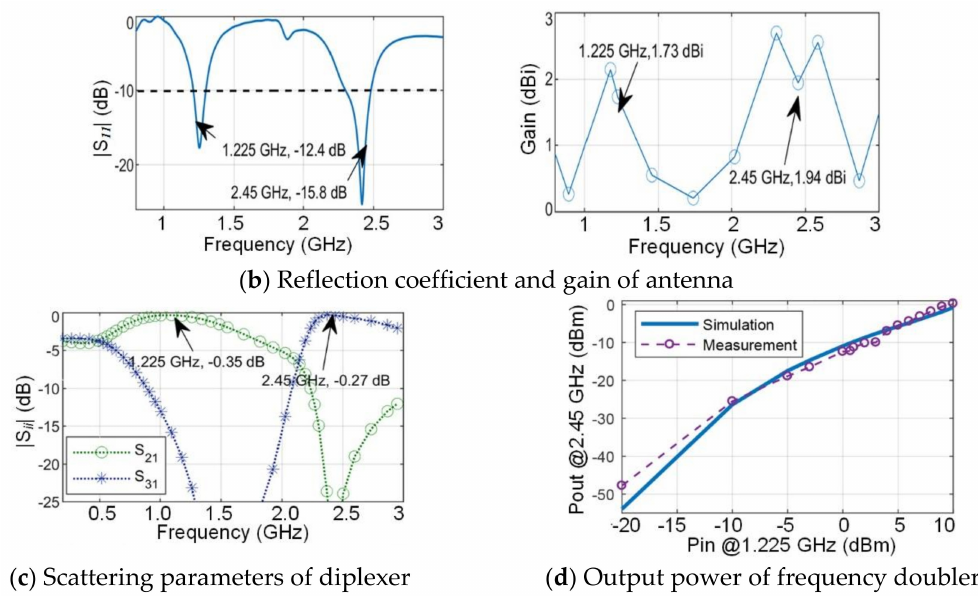
Figure 5. Measurement results of sub-circuits.